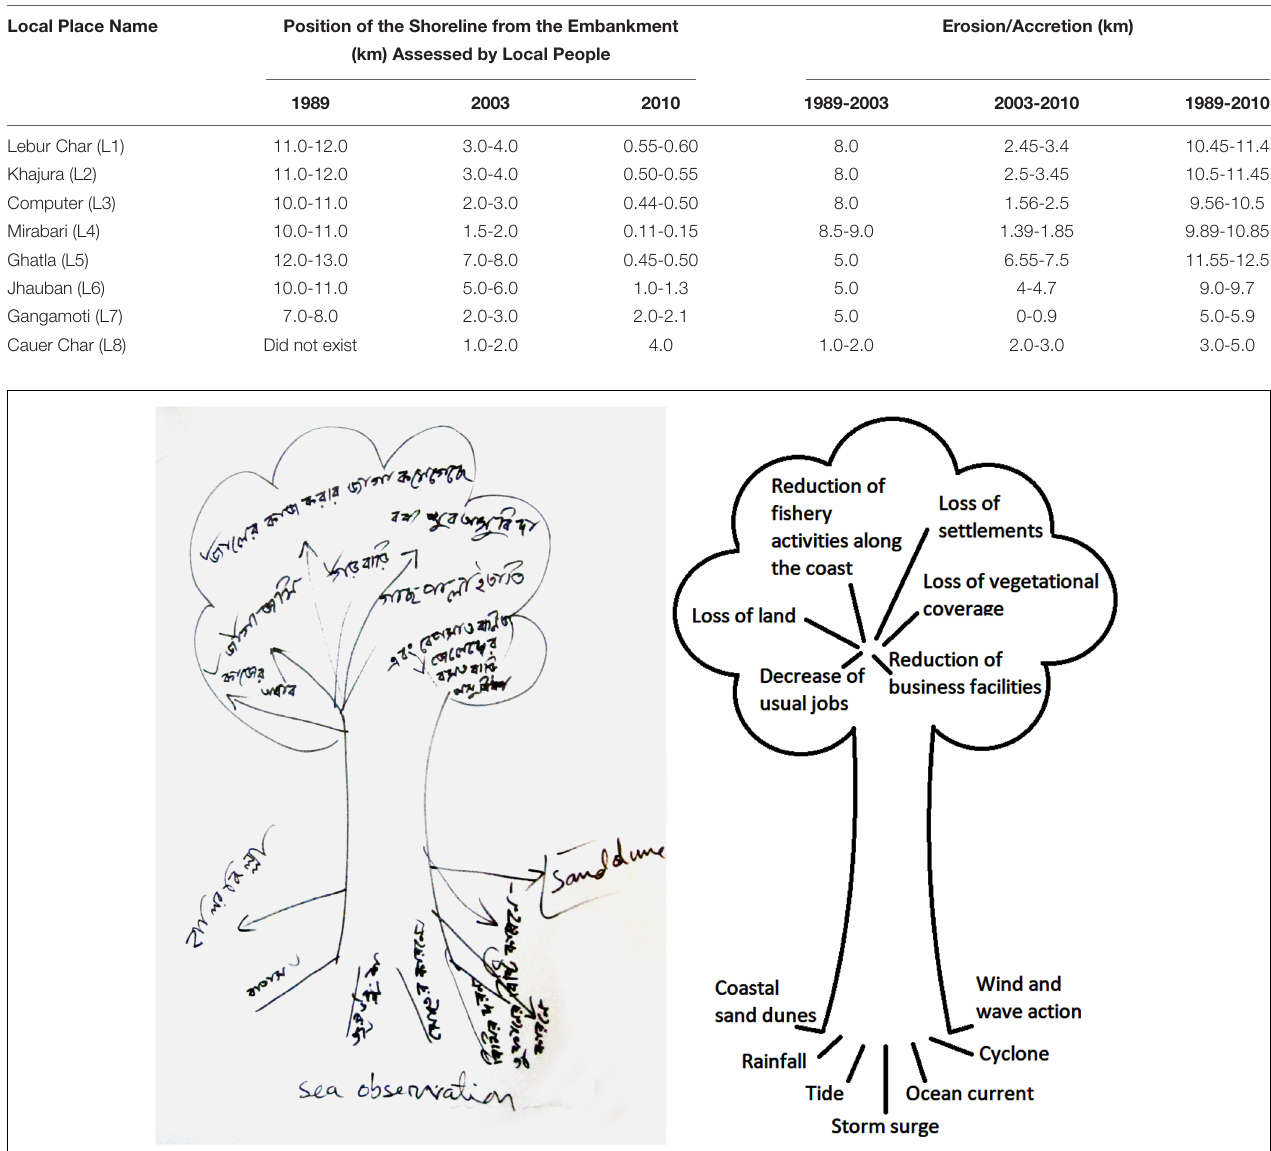
TABLE 2 | Tentative positions of the shoreline at different locations from the embankment, according to the timeline analysis by local people.